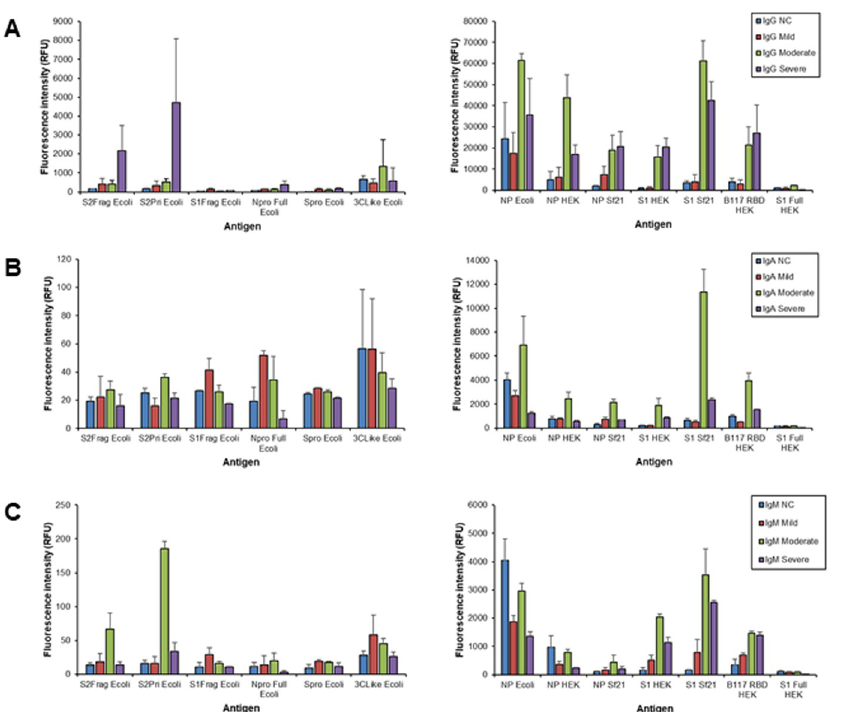
Fig 2. Bar charts representing the binding intensity of purified antibody isotypes from a selected patient from each cohort to immobilised antigen detected by fluorescently-labelled anti-isotype antibodies. (A) IgG, (B) IgA, and (C) IgM. Non-COVID-19 (NC) sample NC1, mild patient 203–0077, moderate 203–0009, and severe 203–0004. Data from the same experiments are represented as two separate bar charts, one for low and one for high binding